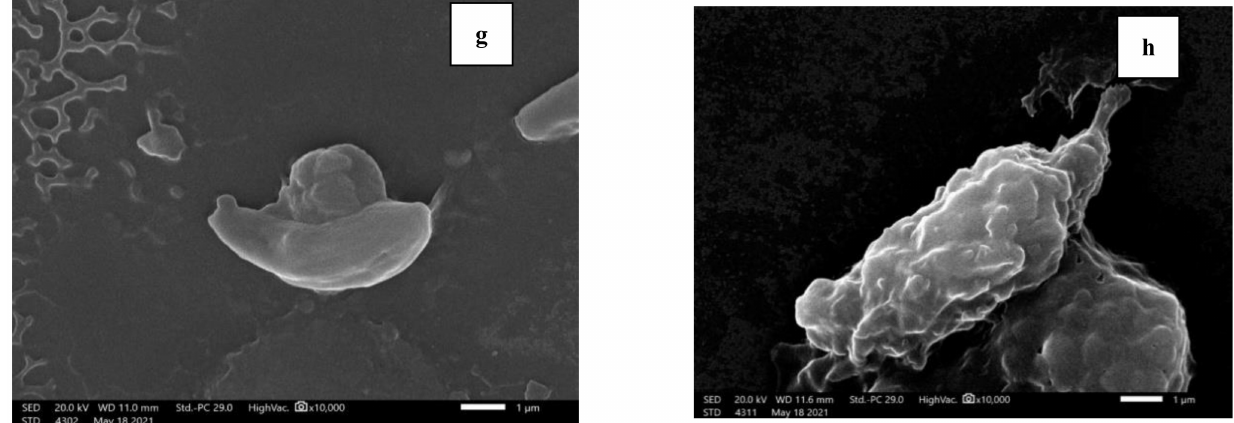
Figure 8. SEM of T. gondii tachyzoites collected from the peritoneal cavity of infected mice from different studied subgroups. ( a ): Tachyzoite from subgroup Ia (infected untreated control), presenting crescent shape with obvious conoid ( × 10,000). ( b ): Tachyzoite from subgroup Ib , showing evident ballooning, distortion of the crescent shape with multiple large papules on the surface and loss of the tapered ends. ( × 10,000). ( c ): Tachyzoite from subgroup IIa , showing loss in the crescent shape with disorganized lacerated outer surface ( × 10,000). ( d ): Tachyzoite from subgroup IIb , showing a shrunken distorted organism losing its crescent shape, tapered ends and conoid with marked surface erosion and ulceration ( × 10,000). ( e ): Tachyzoite from subgroup IIc , showing mutilated rapturing organism losing its conoid with disorganized lacerated surface ( × 10,000). ( f ): Tachyzoite from subgroup IId , indicating lacerated parasite losing its smooth surface ( × 10,000). ( g ): Tachyzoite from subgroup IIe , showing rapturing mutilated organism losing its conoid and smooth surface ( × 10,000). ( h ): Tachyzoite from subgroup IIf , showing disfigured rapturing parasite with marked ballooning along with damaged crescent shape and loss of the tapered ends ( ×